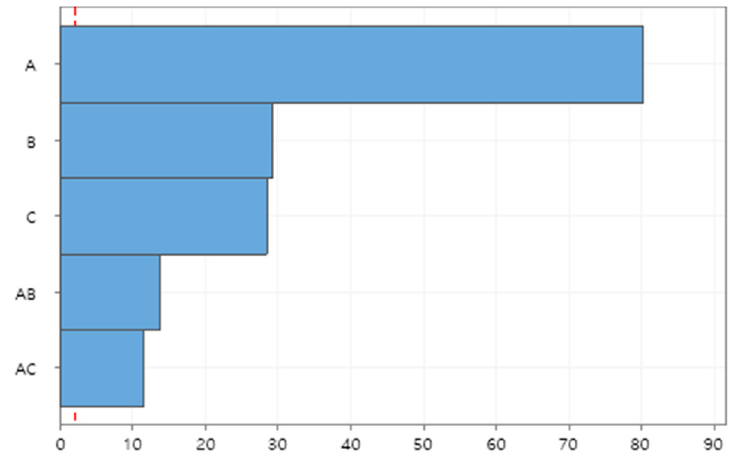
Figure 4. Pareto chart of standardized effects on peak number of